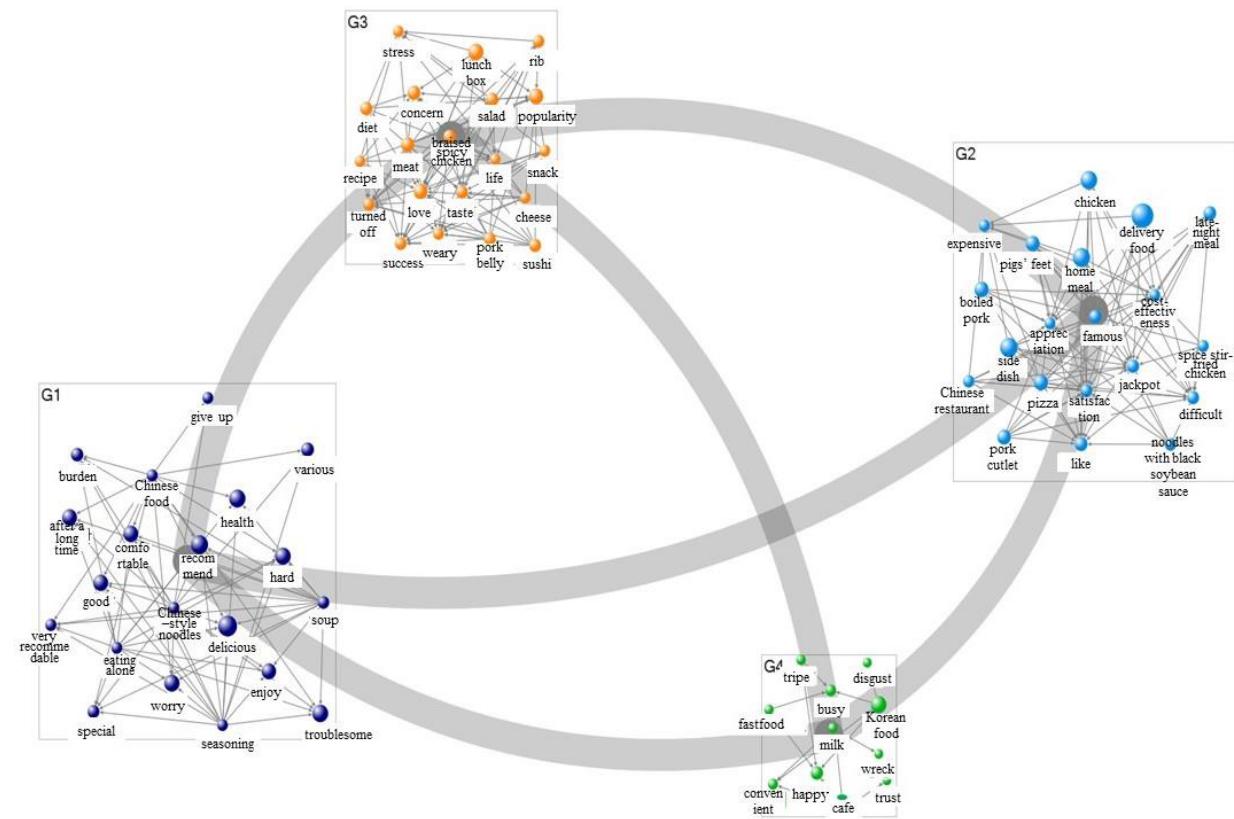
Figure 1. Sentimental network visualization of food delivery (2019). Table 6. Sentimental network index of food delivery (2021).